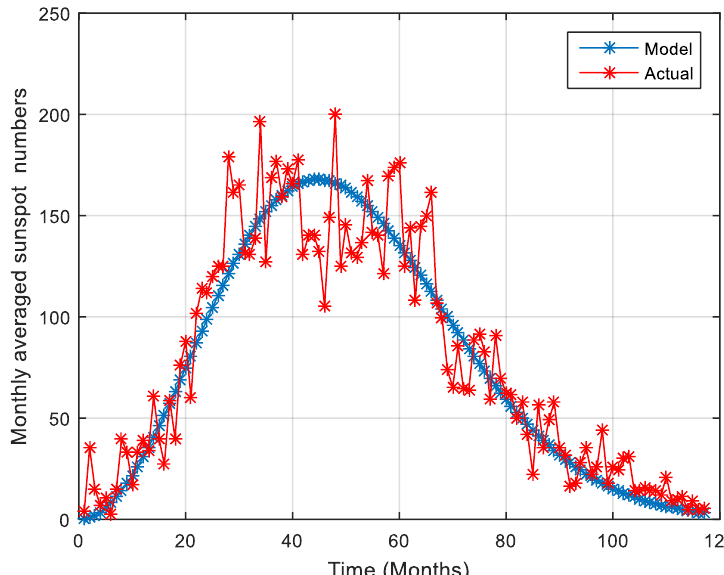
Figure-5. Fitting of sunspot cycle 22 by the model